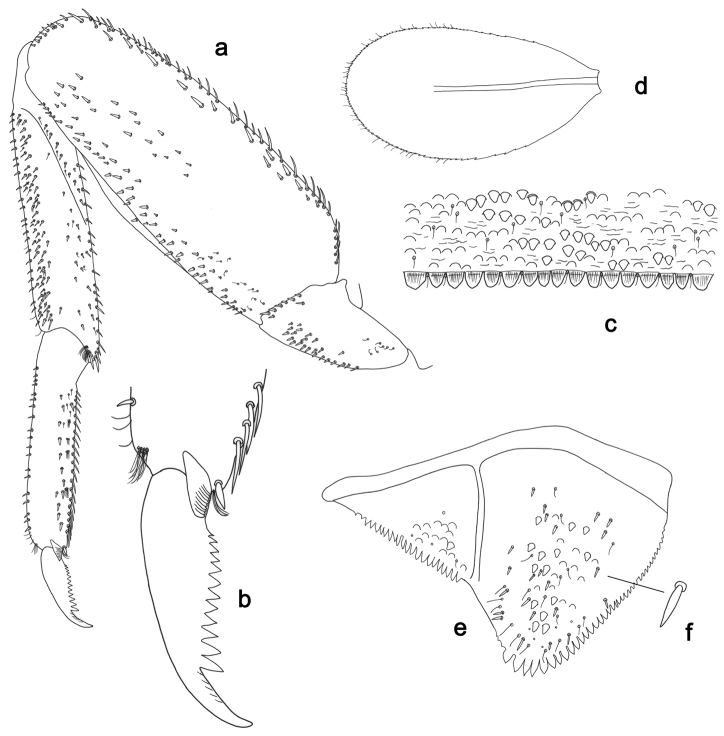
Labiobaetismagnovaldus sp. n., larva morphology: aForelegb Fore claw cTergum IV d Gill IV eParaproctf Seta on paraproct surface.